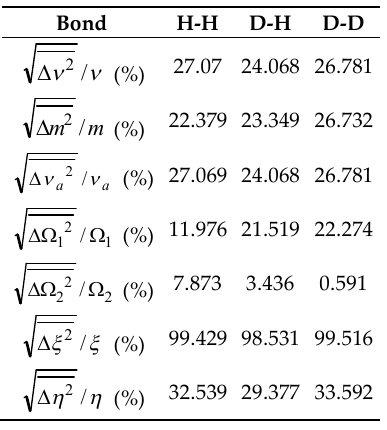
Table 8. Square roots of mean-square relative fluctuations of the distribution function parameters divided by the according parameters (in percent).